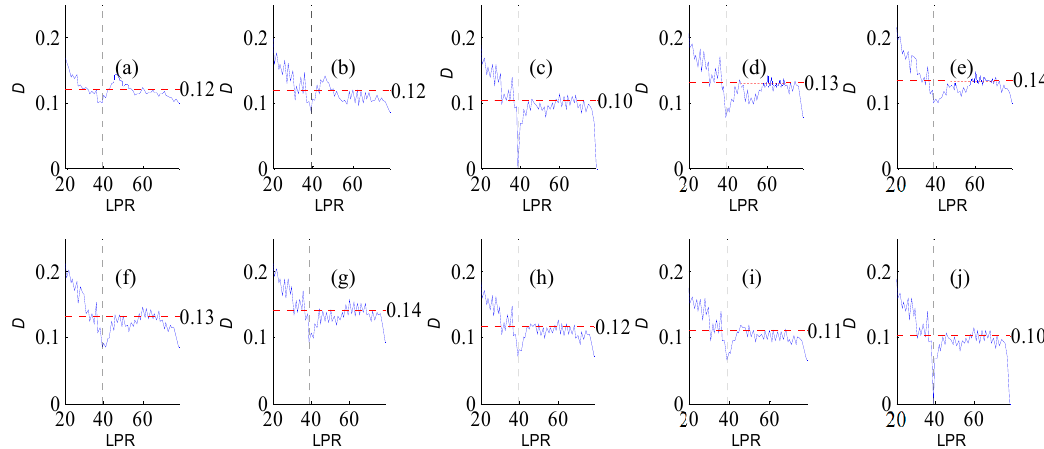
Figure A29. Variation of flow regime alteration degree (D) measured by the RVA with change in the length of pre-impact flow time series (LPR) under a periodicity of 39 years. ( a – j ) correspond to pre-impact flow time series length = 28, 33, 39, 45, 50, 56, 61, 67, 72, and 78 years, respectively. The abscissa value for the vertical dotted line is 39. The ordinate value for the horizontal dotted line is the mean degree of flow regime alteration in each subfigure.